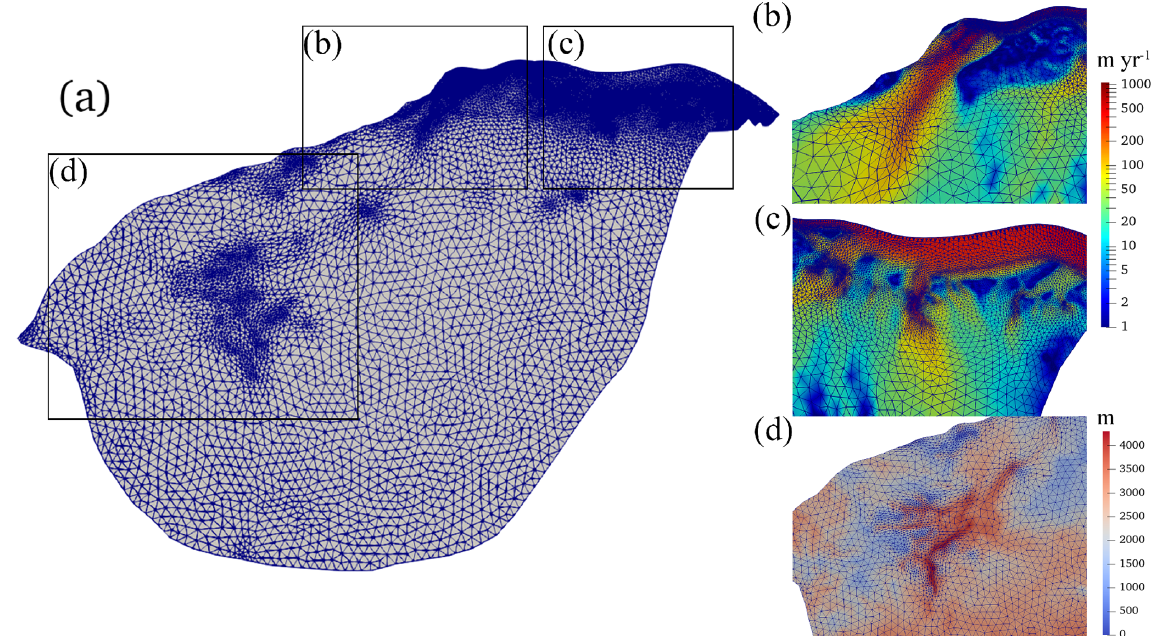
Figure 4. The refined 2D horizontal domain footprint mesh (a) . Boxes outlined in panel (a) are shown in detail and overlain with surface ice velocity in panels (b) and (c) and with ice thickness in panel (d)